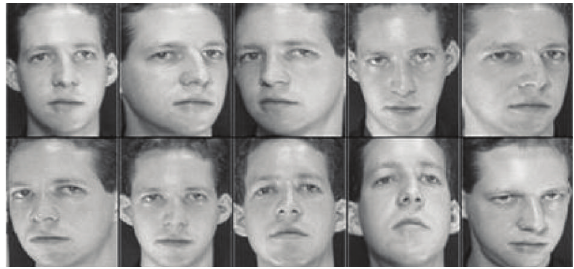
Figure 1: Images of one person from ORL database.